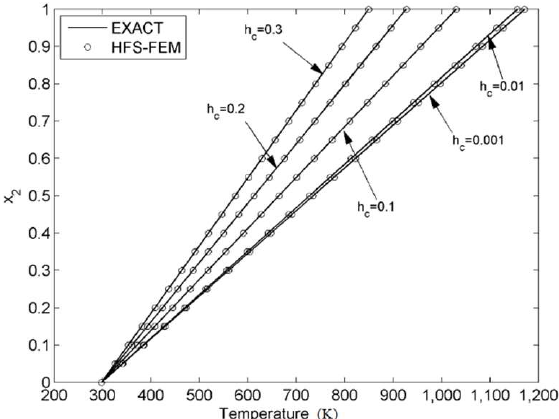
Figure 9. Temperature variation along the middle line x 1 = 0.5mm for different coating thicknesses for linear